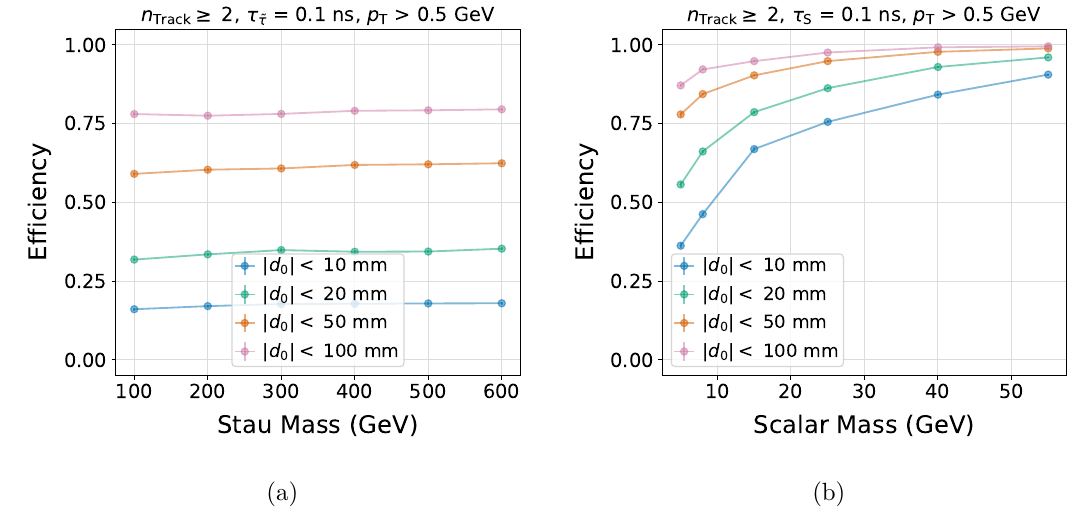
Figure 29. Event-level efficiency for different | d 0 | endpoints as a function of long-lived particle mass. Both the stau (a) and Higgs portal model (b) have lifetimes of τ = 0 . 1 ns. Only displaced tracks produced in the long-lived particle decay are considered. Effects of the p minimized by requiring p 0 . 5 GeV, and both long-lived scenarios require n T >